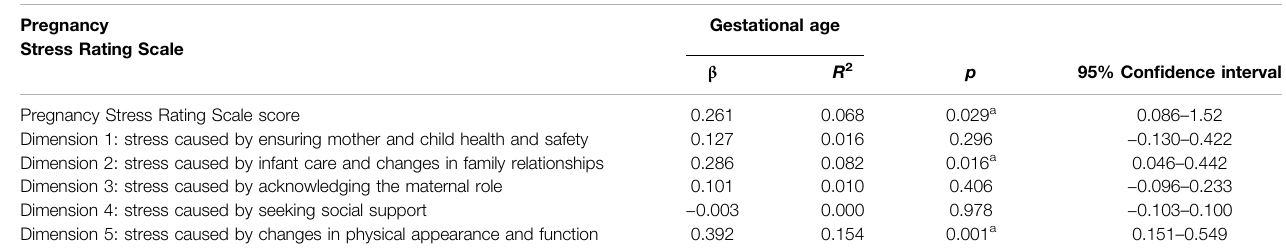
TABLE 4 | Gestational age and pregnancy stress ( n = 70). Pregnancy Stress Rating Scale